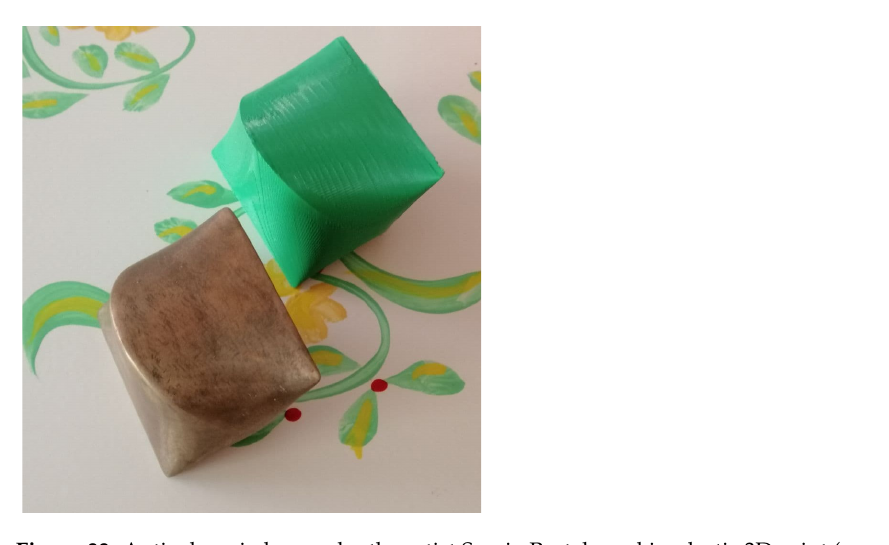
Figure 33. Antisphera in bronze by the artist Sergio Portela and in plastic 3D print (green).